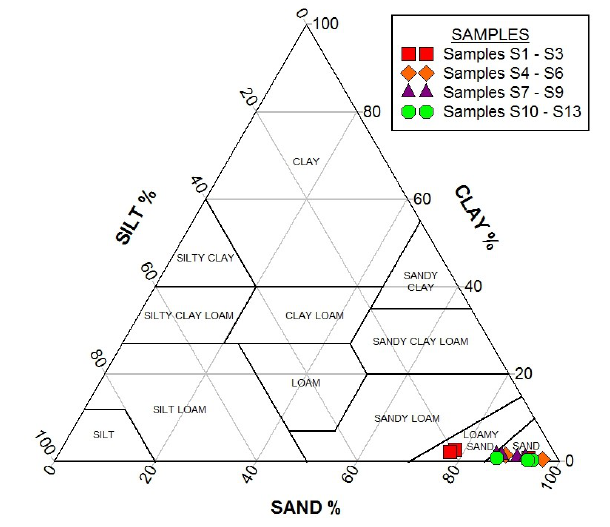
Figure 2. US Department of Agriculture (USDA) soil-texture trian- gle showing the grain size plot of the 13 samples collected for this study. Volume size-class fractions grouped as clay ( < 2µm), silt (2– 62.5µm) and sand (62.5–600µm).